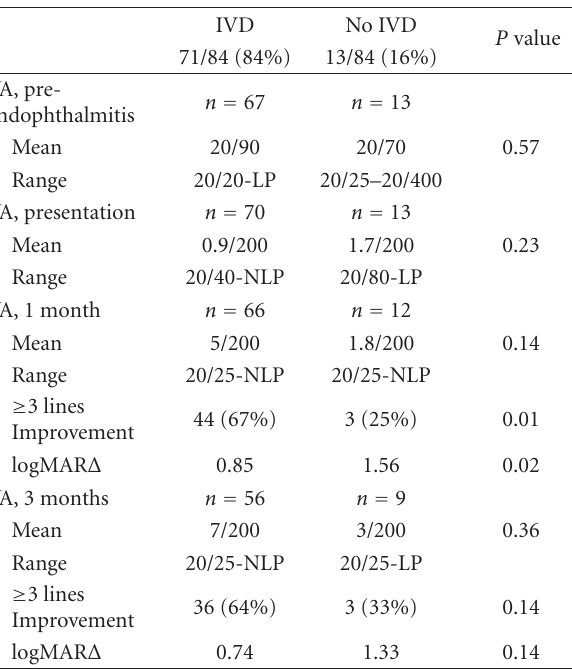
Table 3: VA outcomes.